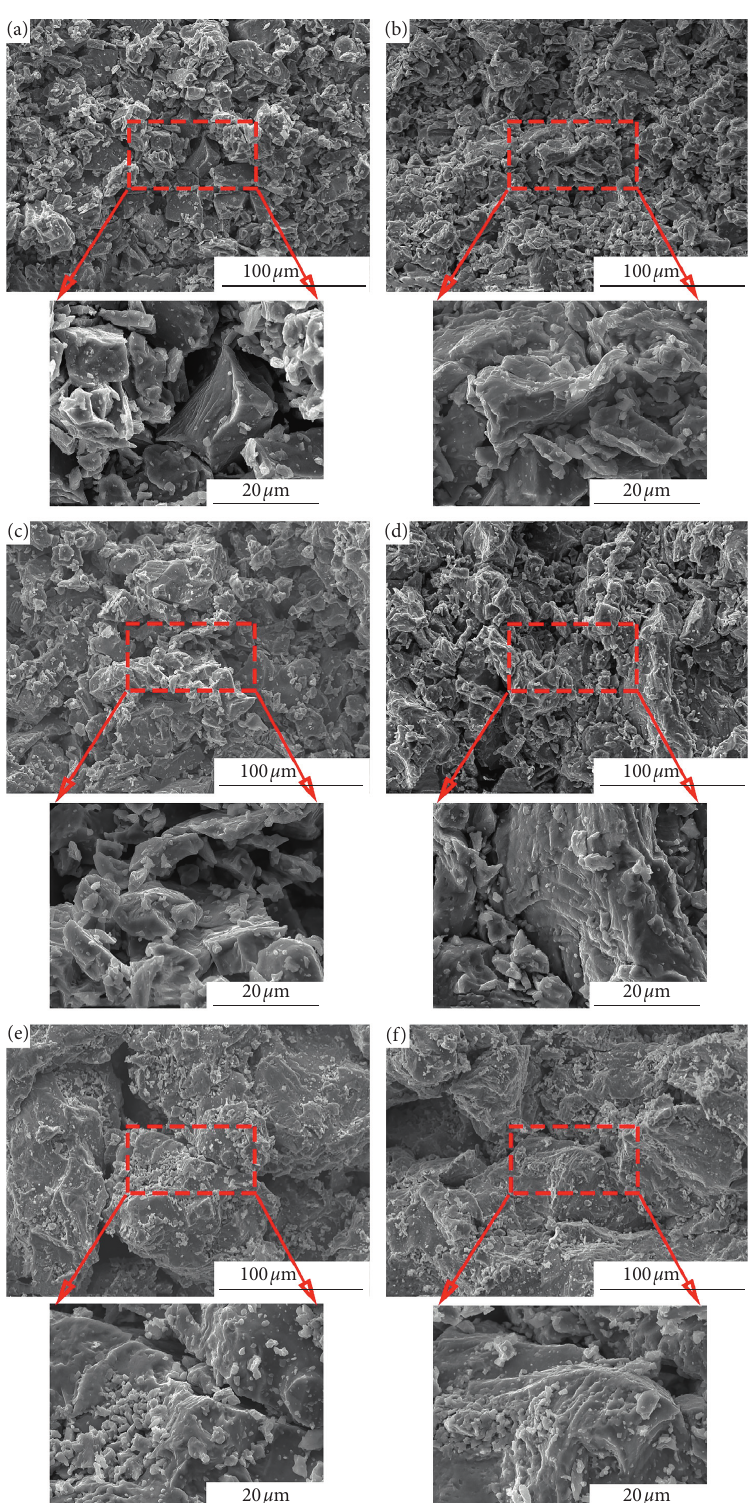
Figure 12: SEM images of HDH titanium green compacts: (a) 0–38 μ m 250MPa, (b) 0–38 μ m 650MPa, (c) 0–125 μ m 250MPa, (d) 0–125 μ m 650MPa, (e) 88–125 μ m 250MPa, and (f) 88–125 μ m